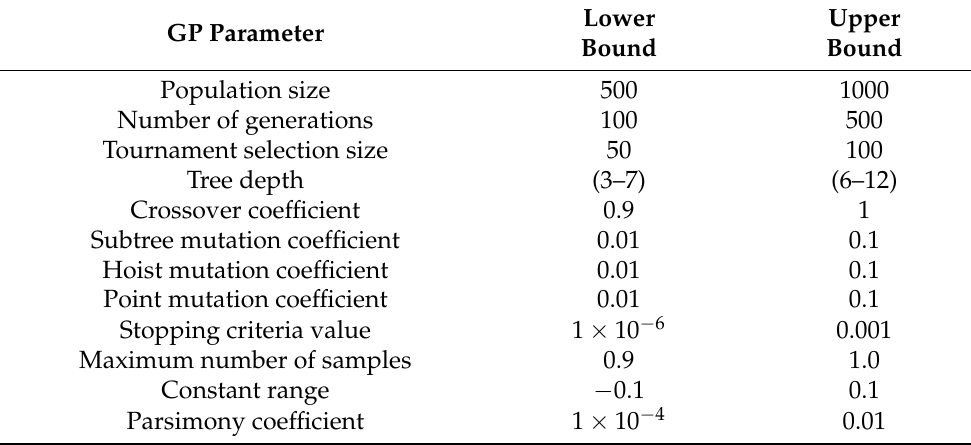
Table 3. The range of GP parameters used in all